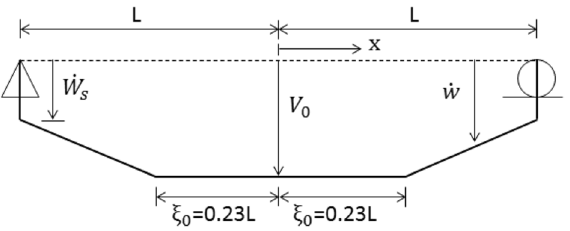
Figure 15. Distribution of transverse velocity during the shear dominant the first phase of motion ( ν > 1.5 ).